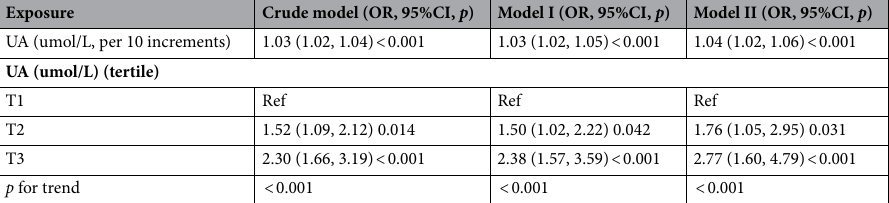
Table 3. Relationship between Uric acid and in-hospital mortality in different models. Crude Model adjusted for none. Model I adjusted for age, gender, BMI, smoking, hypertension, diabetes, Marfan syndrome, Bicuspid aortic valve, CRI, stroke, atherosclerosis, time to presentation, SBP, DBP, aortic diameter, aortic regurgitation, abdominal vessel involvement, arch vessel involvement, EF value, Cr, BUN, eGFR, TG, TC, HDL, LDL, D-dimer, FDP, CRP. Model II adjusted for Model I and symptom, coronary malperfusion, mesenteric malperfusion, cerebral malperfusion, hypotension/shock, cardiac tamponade and operation. BMI body mass index, SBP systolic blood pressure, DBP diastole blood pressure, Cr creatinine, BUN blood urea nitrogen, eGFR estimated glomerular filtration rate, UA uric acid, TG triglyceride, TC total cholesterol, HDL high-density